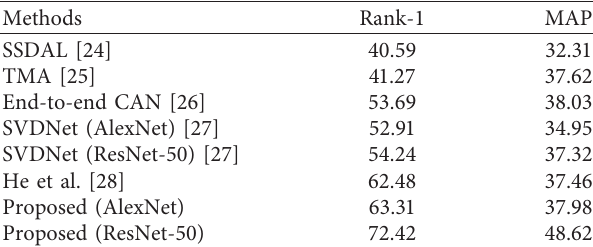
Table 3: The comparison results with VeRi-776 datasets. Methods Rank-1